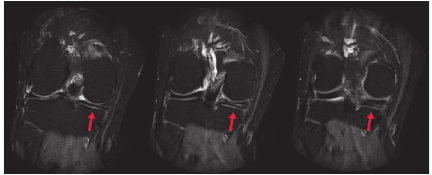
Figure 3: Coronal Proton Density (PD) fat suppression (FS) mag- netic resonance imaging showing the chondral flap with an appear- ance similar to that of a torn medial meniscus (arrow). No underly- ing bone edema is seen.